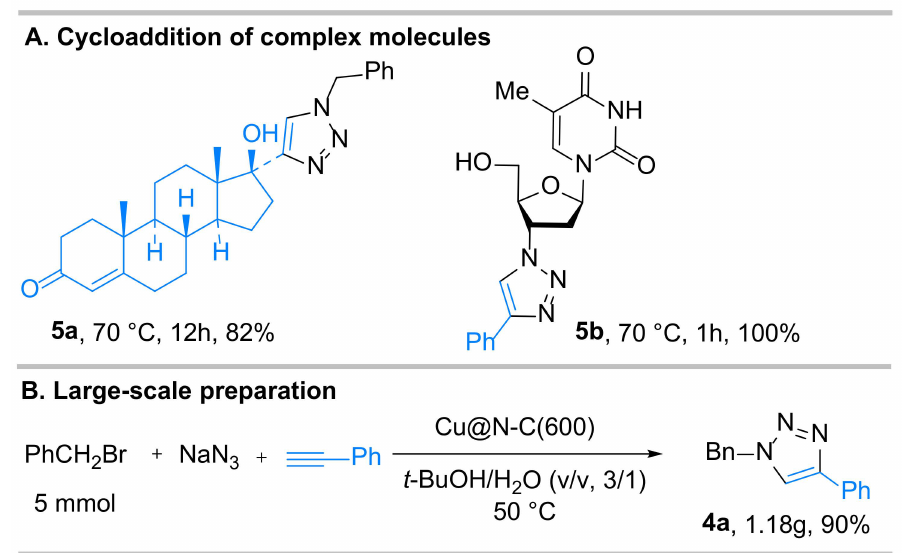
Figure 4. Synthetic applications and large-scale preparation.